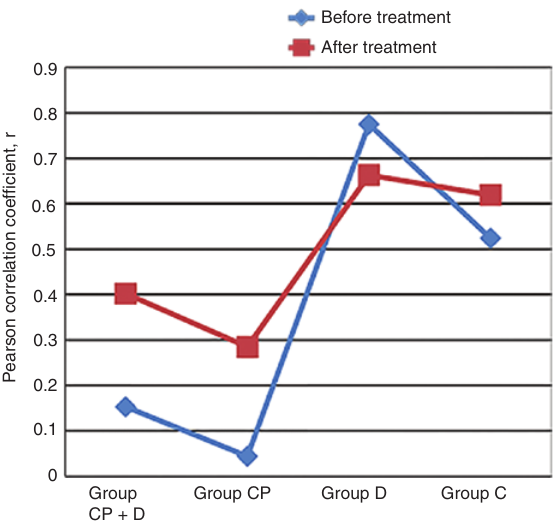
Figure 4: Intergroup correlation of salivary neopterin and HbA levels before and after